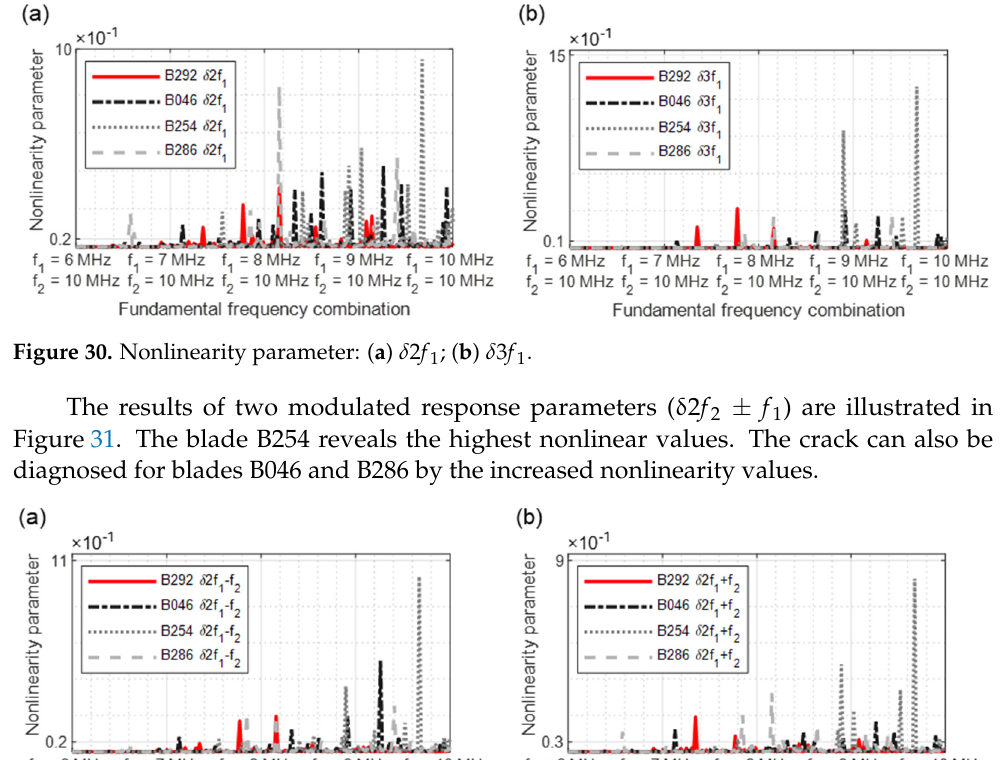
− f 1 2 ; ( b ) δ 2 f 1 + f 2